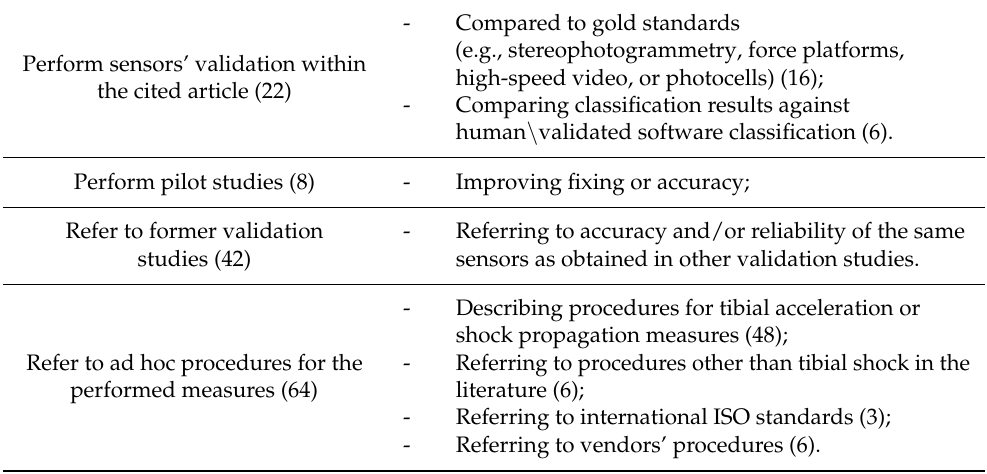
Table 2. Breakdown of approaches used for sensor